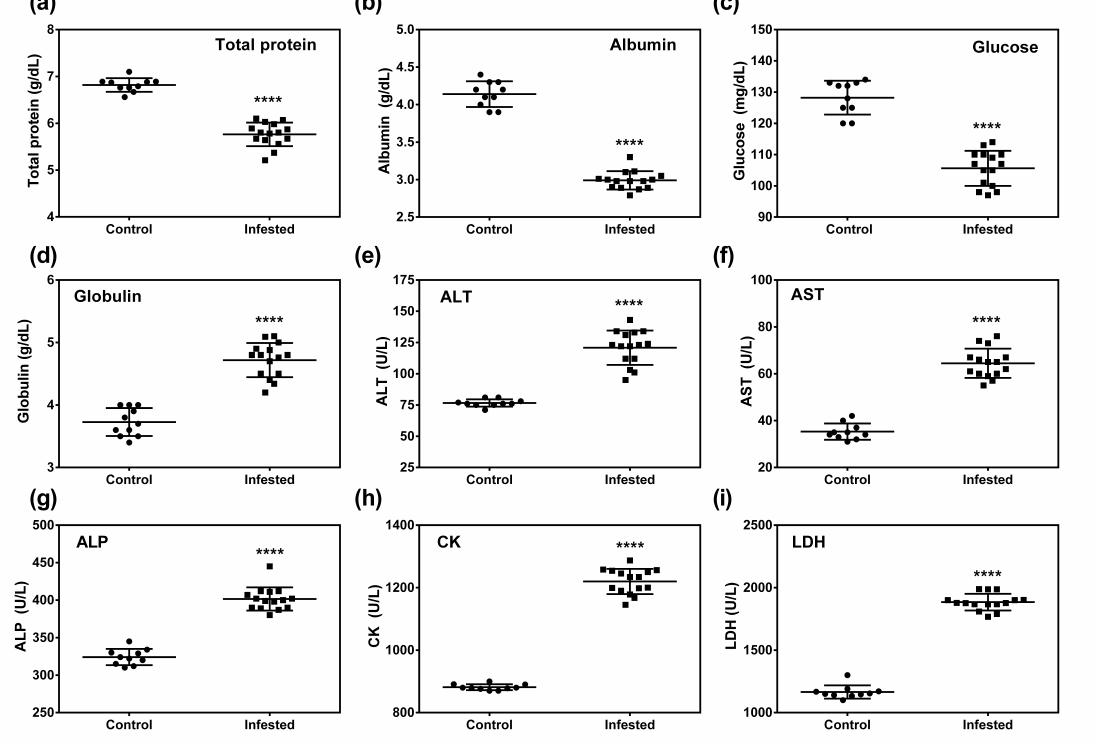
Figure 3. E ff ect of crusted scabieson serum biochemical parameters in a porcine model. ( a ) Serum total protein, ( b ) serum albumin, ( c ) serum glucose, ( d ) serum globulin, ( e ) alanine aminotransferase (ALT), ( f ) aspartate aminotransferase (AST), ( g ) alkaline phosphatase (ALP), ( h ) creatine kinase (CK), ( i ) lactate dehydrogenase (LDH). Data in scatter plot are shown as mean ± SD. t -test was performed to find out significant di ff erence between the two groups. **** denotes p ≤